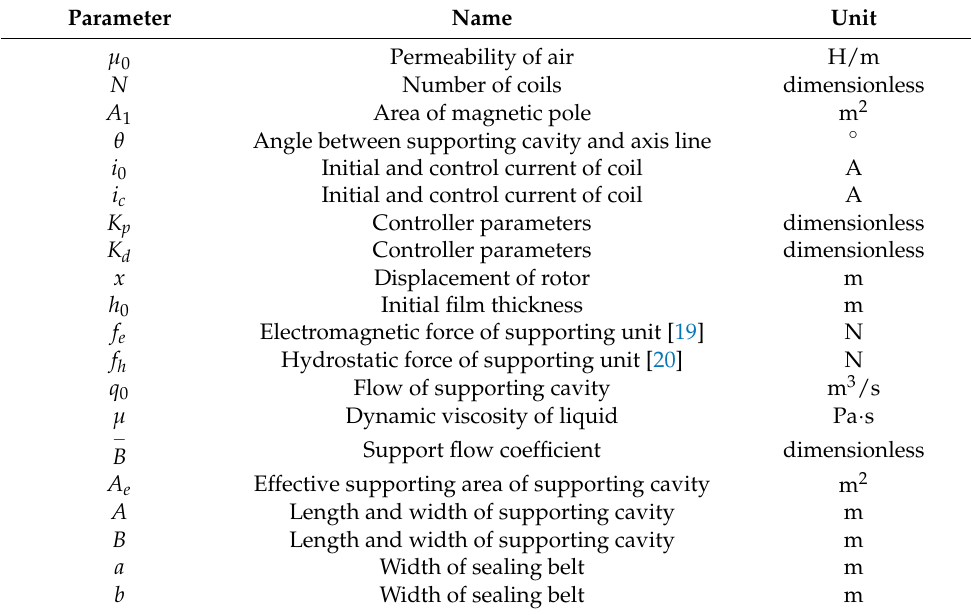
Angle between supporting cavity and axis